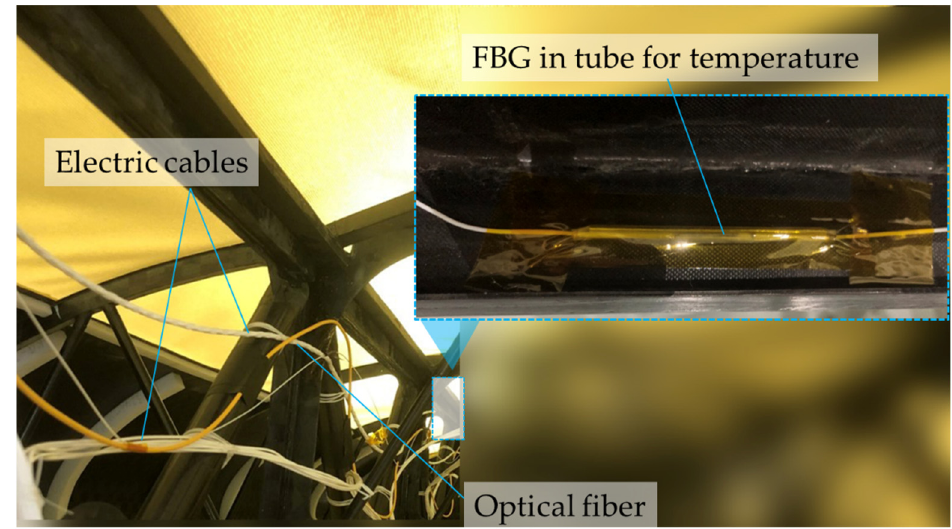
Figure 5. Wing interior and sensor attachment on the wing spar.